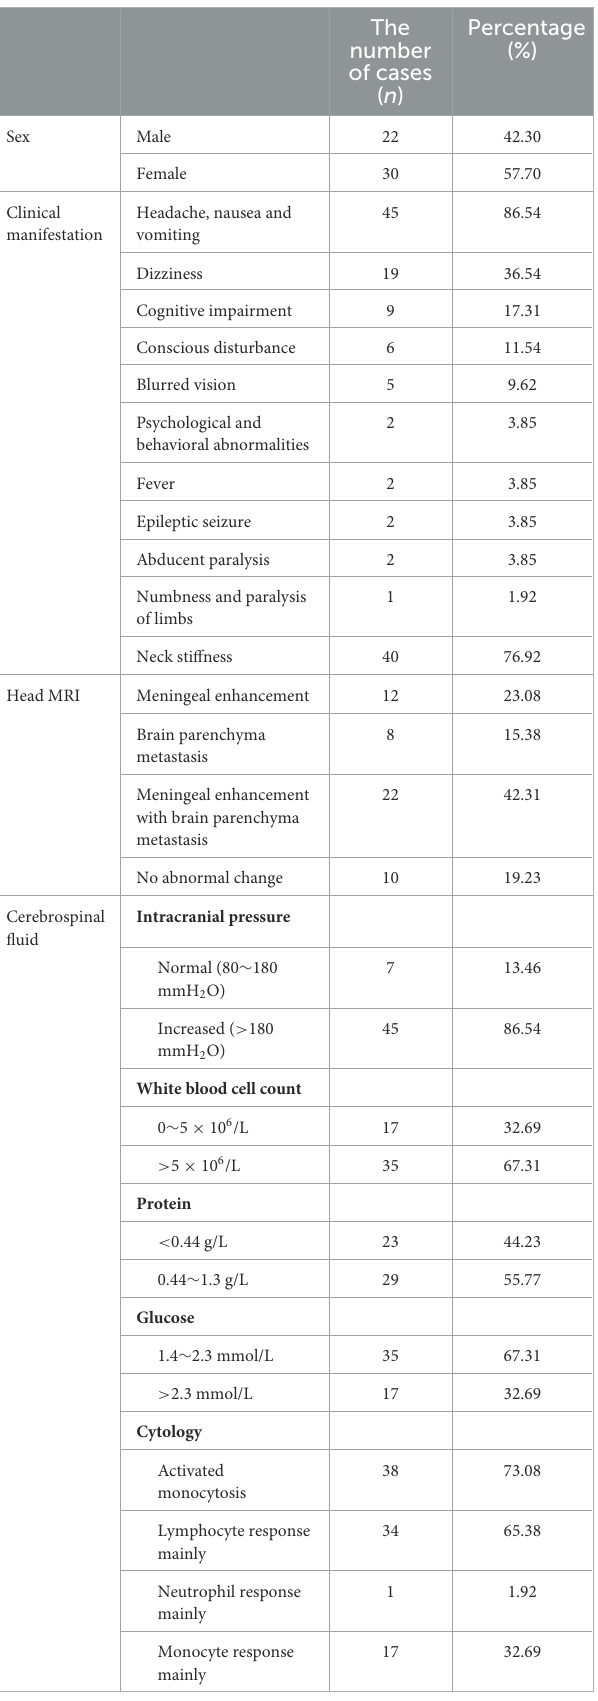
TABLE 1 General data of 52 patients with MC. TABLE 2 Comparison of positive rate of CSF cytology and head MRI of 52 patients with MC.